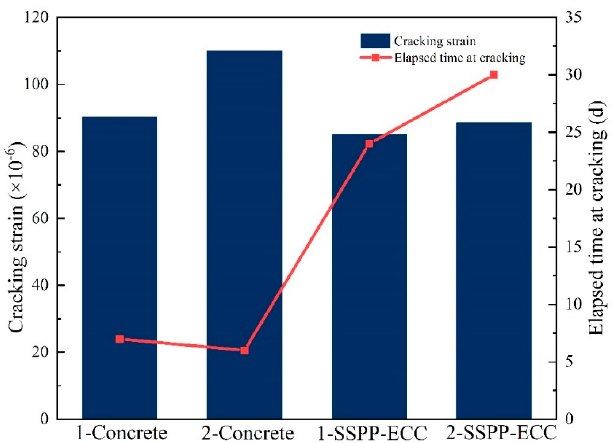
Figure 19. Cracking strain and cracking time of concrete and SSPP-ECC.